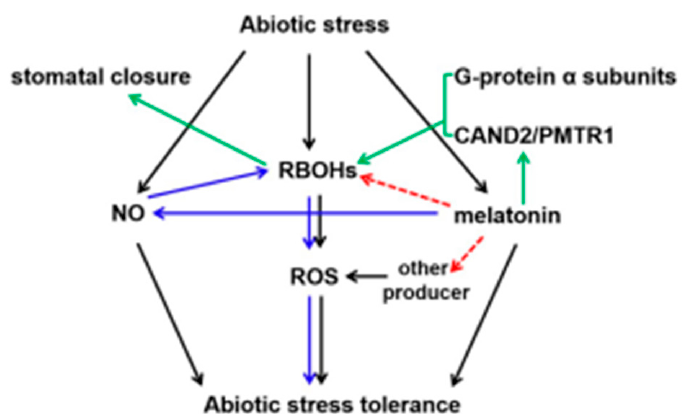
Figure 2. Probable integrative model of ROS with melatonin regulator in plant responses to abiotic stress. Increasing evidence shows that melatonin induces NO generation and enhances RBOH activity through denitrosylation, thereby activating ROS signaling in tomatoes (blue arrow). Interaction between CAND2/PMTR1 (the melatonin receptor) and G-protein α subunits activates RBOHs, resulting in stomatal closure (green arrow). The direct relationship between the melatonin and RBOHs in plant tolerance to abiotic stress is still largely unknown (red arrow, yet largely unknown). NO, nitric oxide; ROS, reactive oxygen species; RBOHs, respiratory burst oxidase homologs.